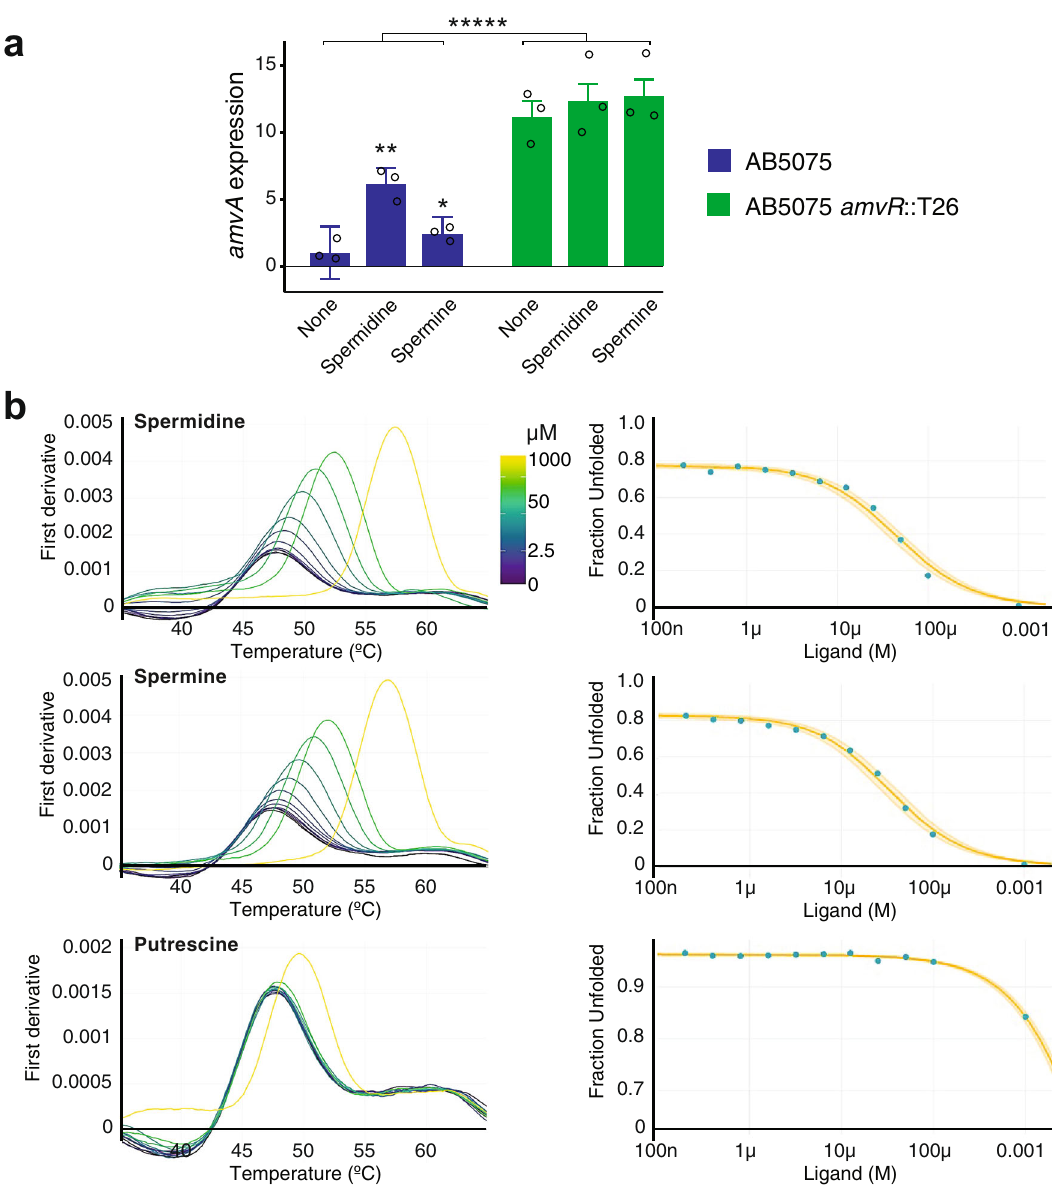
Fig. 4 AmvR and long-chain polyamines control amvA expression. a AmvR-dependent induction of amvA by long-chain polyamines. Quantitative real- time PCR of amvA transcript in AB5075 and AB5075 amvR ::T26 following addition of long-chain polyamines at 1/16 WT MIC (10 mM spermidine, 2 mM spermine). AB5075 amvR ::T26 showed dramatically increased amvA transcript levels, which did not increase further on polyamine addition. All fold changes are expressed relative to the untreated AB5075 control. Results shown are the geometric mean ± standard deviation of three biological replicates, which were each comprised of two technical replicates. A two-factor ANOVA showed a signi fi cant effect of strain background (***** p < 0.00001) and polyamine treatment ( p = 0.0013, comparison not shown) on amvA expression levels. A one-way ANOVA with Dunnett ’ s post hoc test was used to compare polyamine-treated samples with the untreated sample of the same strain (* p < 0.05, ** p < 0.01). b Nano-DSF analysis of puri fi ed AmvR shows spermine and spermidine binding at low µ M af fi nity. Melt curves and fi tted unfolded protein fraction are shown for AmvR in the presence of increasing polyamine concentrations. Spermidine and spermine prevented protein unfolding at low concentrations (<10 µ M), while putrescine only in fl uenced protein unfolding at the highest concentration of 1 mM. The complete experiment was performed in duplicate, and results from the second replicate are provided in Supplementary Fig. 4. Calculated binding af fi nities are provided in Supplementary Tables 3 and